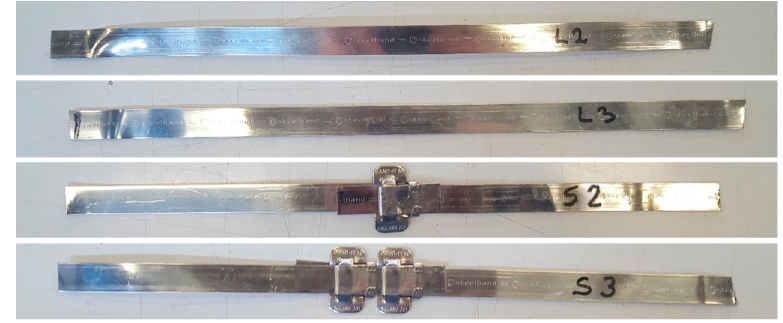
Figure 28. The four specimens for the characterization of the CAM-like ribbons and new junctions.